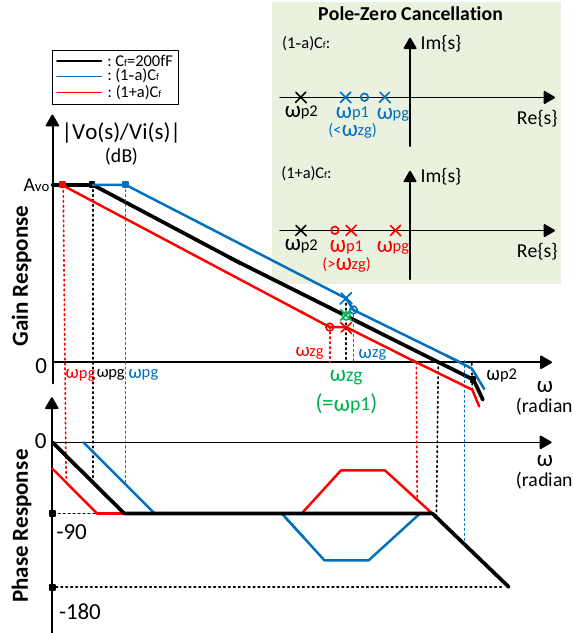
Figure 7. Bode plots of pole-zero cancellation over variations on Miller compensation capacitance for 1–nF load